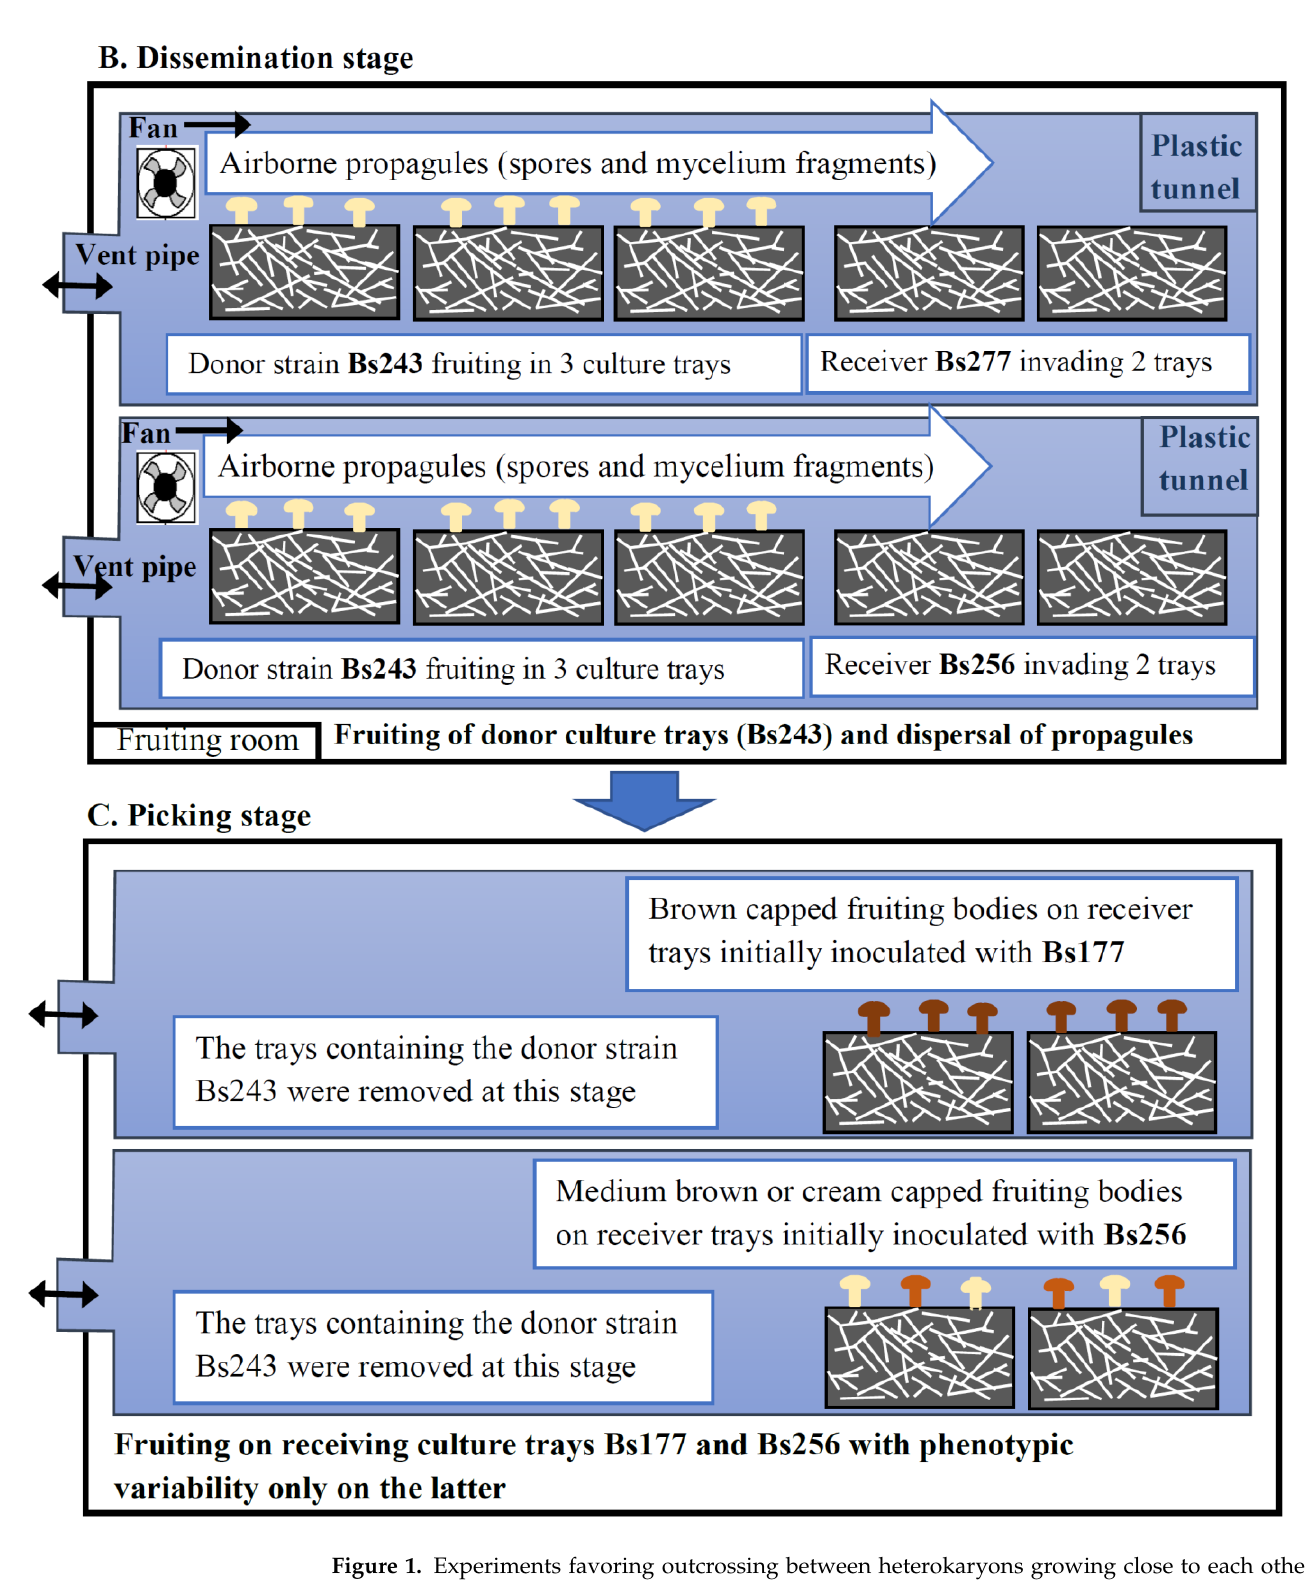
Figure 1. Experiments favoring outcrossing between heterokaryons growing close to each other. ( A ). Schedule of the staggered cultures of donor and receiving mycelia in the incubation room (n°1) and the fruiting room (n°2). The blue arrow shows the 7-day period during which propagules of the donor are disseminated to the receiver (dissemination stage). The red arrow shows the picking period on receiver trays (picking stage). ( B ). Dissemination stage in the fruiting room in which two couples of donor/receiver heterokaryons were isolated in two plastic tunnels. The donor strain (Bs243) was fruiting in first and its airborne propagules were spread on the receiver strain (Bs177 or Bs256) in